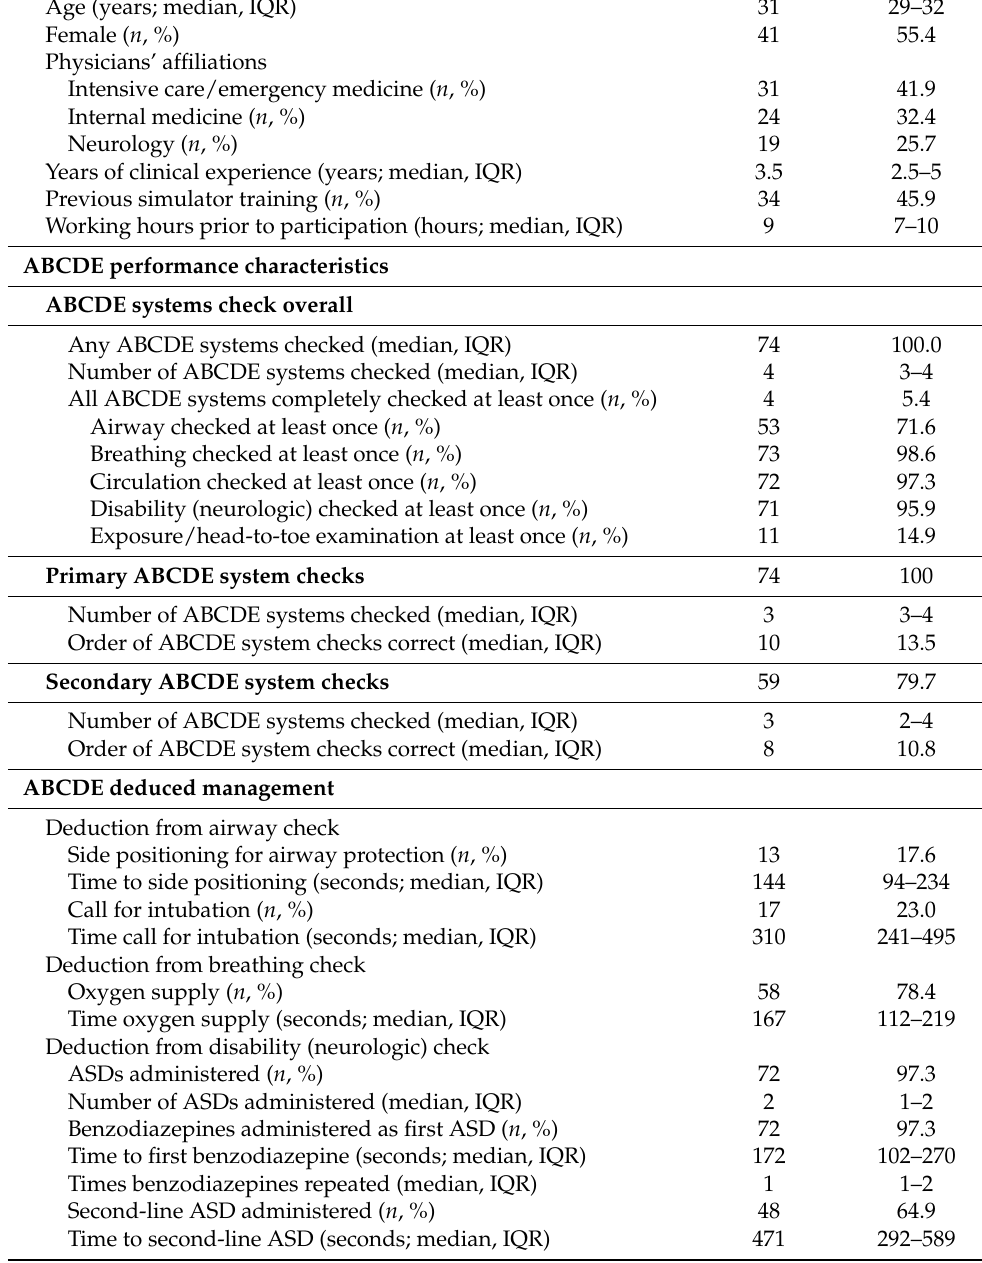
Table 1. Characteristics, clinical assessment, and ABCDE deducted management of participating physicians ( n = 74). SE = status epilepticus; IQR = inter quartile range; ASD = antiseizure drug. Characteristics of